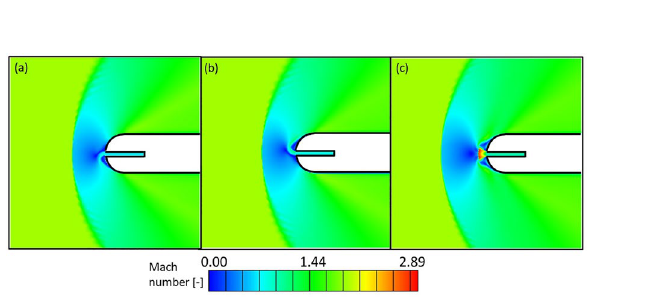
Figure 17. Leading edge region Mach number contours for Re dc = 1.00 × 10 4 and M c = 0.70 ( a ), 0.85 ( b ) and 1.00 ( c ).